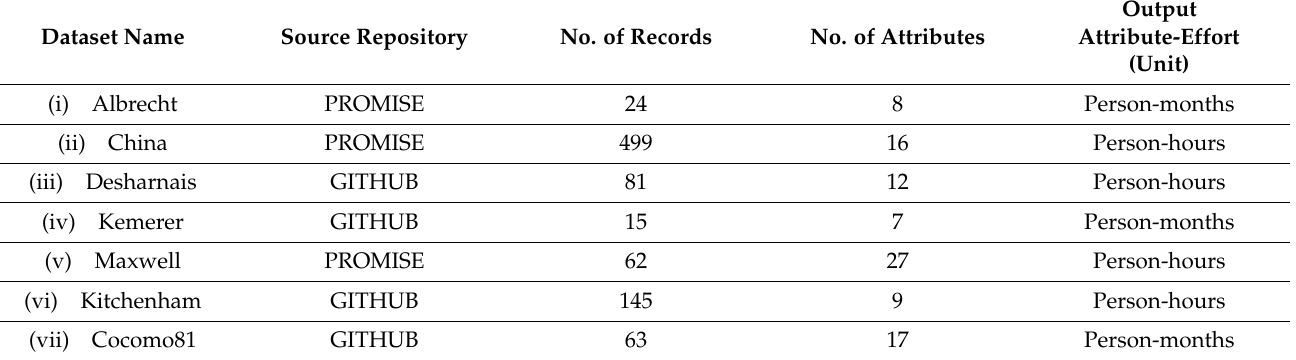
Table 2. Dimensions of the dataset.